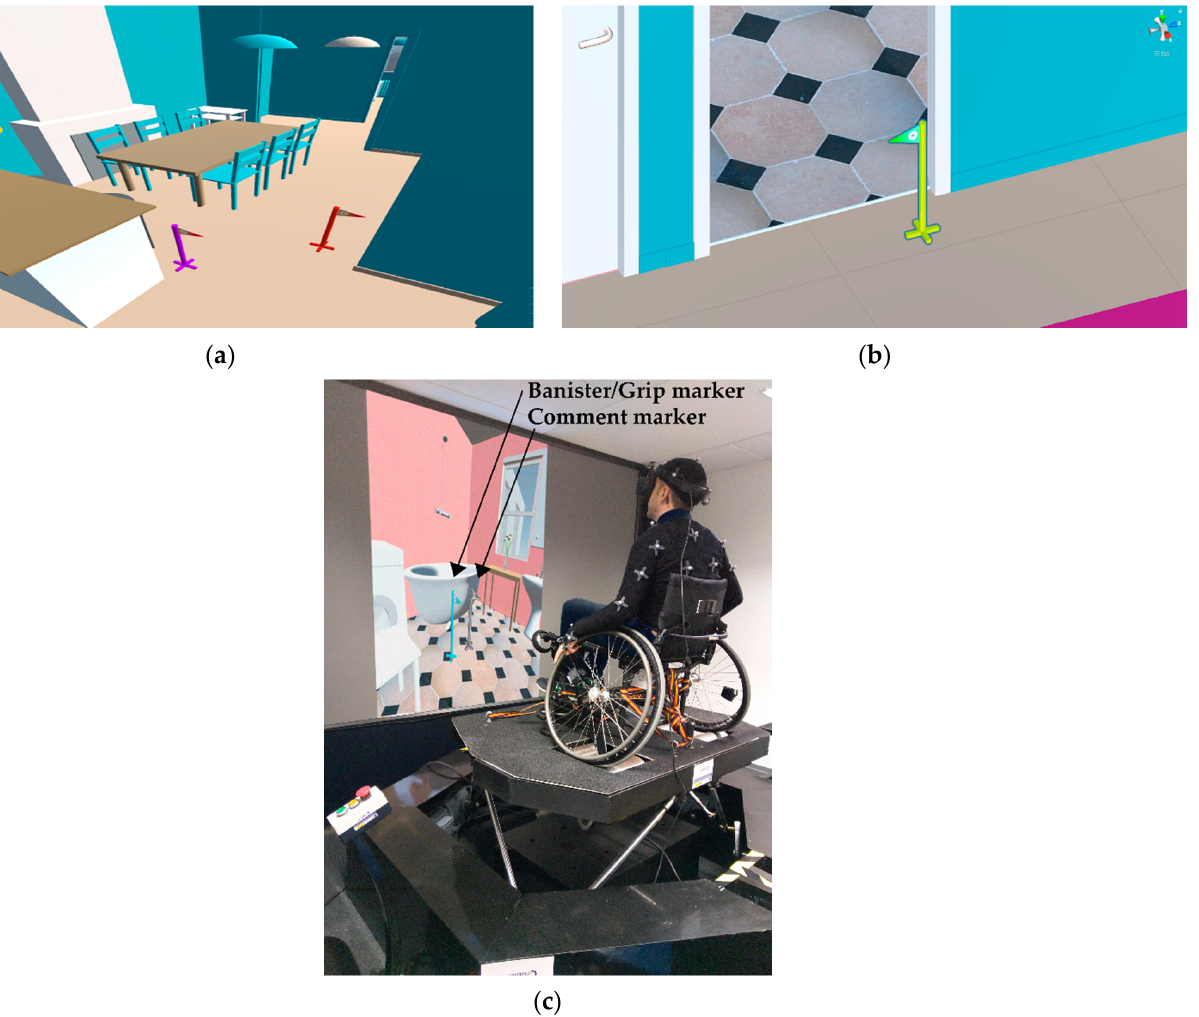
Figure 14. ( a ) A Distribution marker and a manoeuvrability marker placed in the shared area between the dining room and the kitchen; ( b ) step marker at the bathroom entrance to request the inclusion of a ramp to facilitate access; and ( c ) photograph of the evaluator during his visit to the bathroom, where he located the comment and bannister and grip markers.